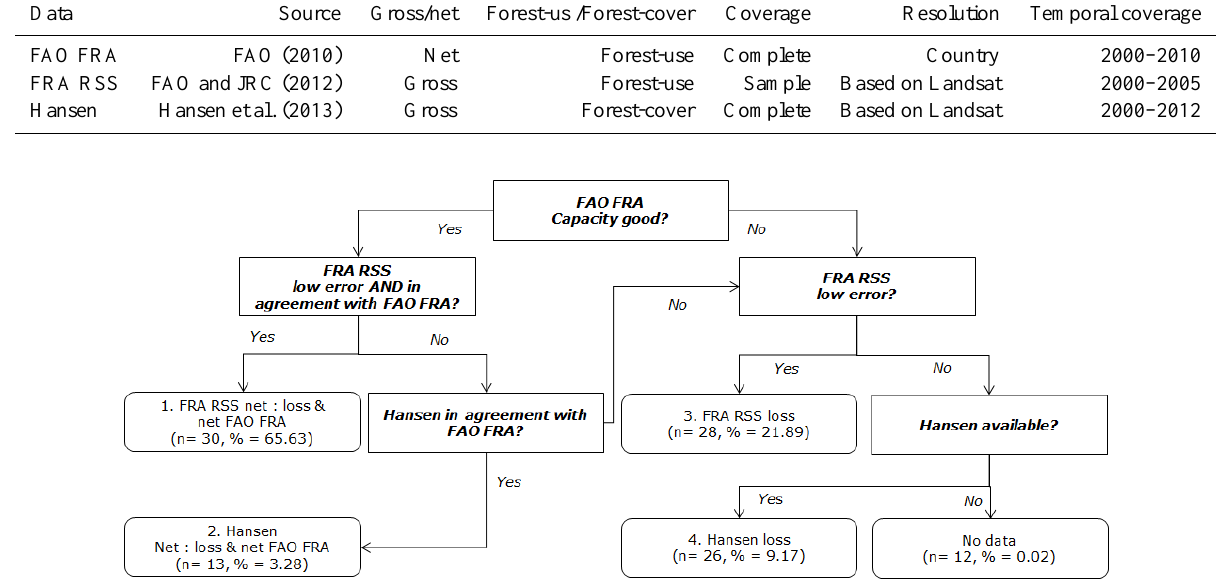
Figure 3. The decision tree for the selection of deforestation data. The decision numbers represent quality flags, 1 for the highest quality data and 4 for the lowest. N = number of countries in that group, and % = percentage of forest in that